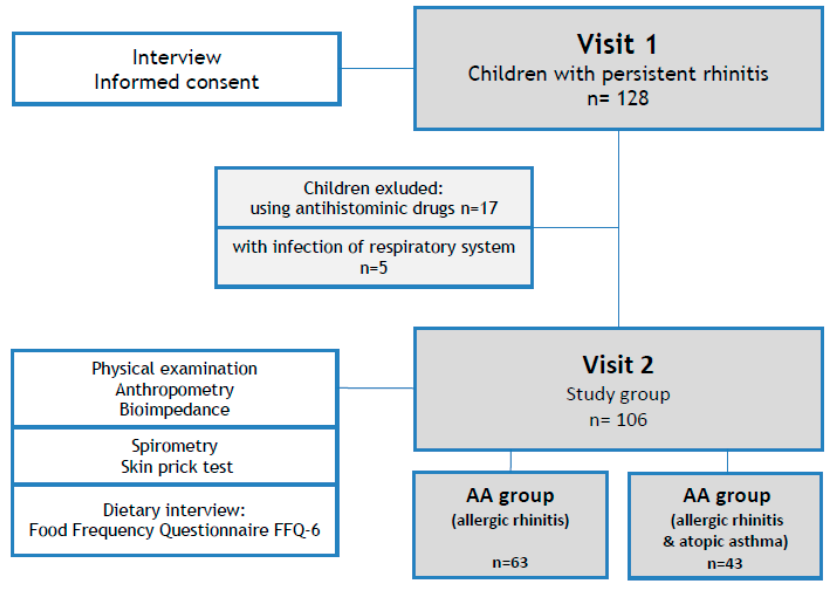
Figure 1. Study Figure 1. Study design.